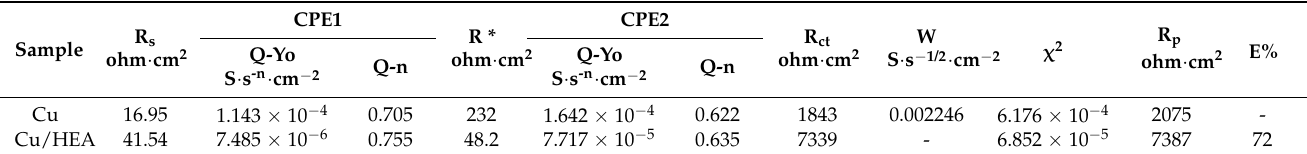
Table 4. The EIS parameters of the Cu and Cu/HEA in artificial sea